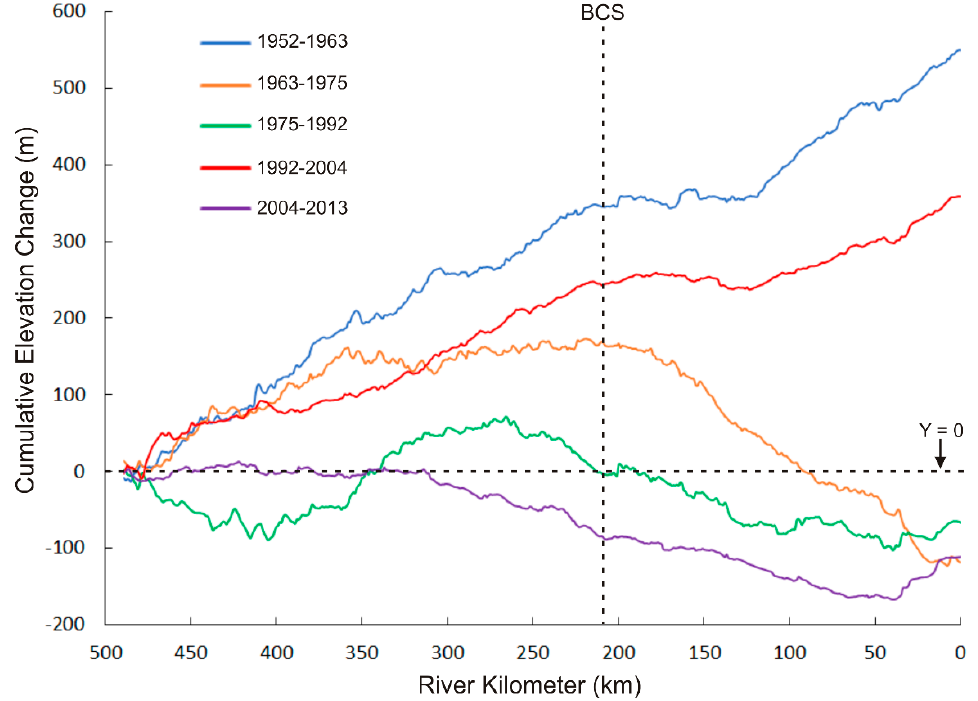
Figure 8. The cumulative elevation changes with the upper reach and lower reach (divided by the BCS) shown by intermediate hydrographic surveys from 1952 to 2013. A positive trend represents sediment deposited on the riverbed, while a negative trend indicates sediment erosion in the study area. Table 3. Vertical trends (degradation, aggradation, or no change) in thalweg profiles during different periods from 1952 to 2013 (See Figure 8). The numbers in this table represent distance in river kilometers (RK; i.e., 205–120 indicates the sub-reach from RK 205–RK 120). Period Degradation